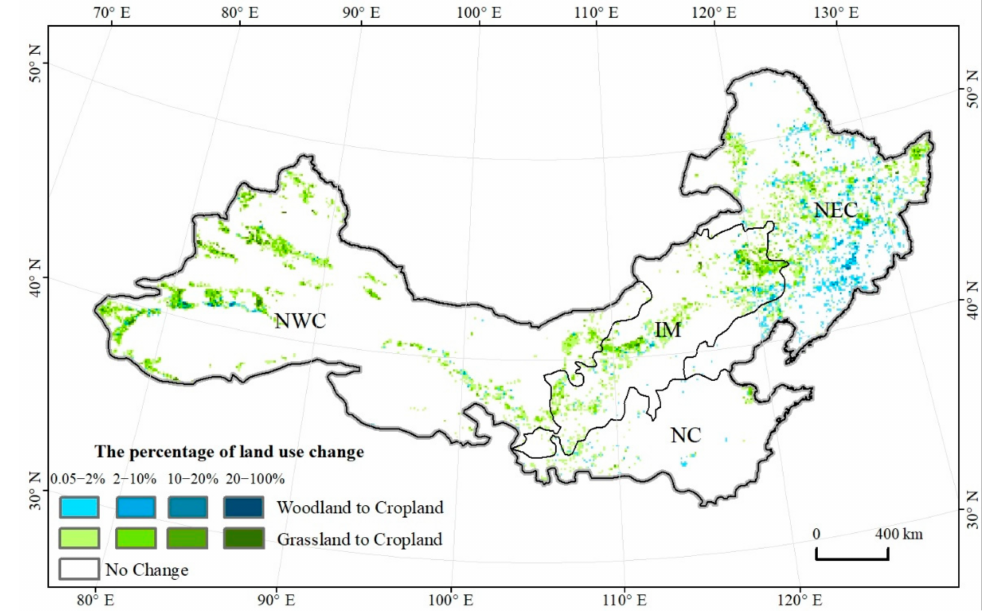
Figure 2. Distribution of cropland expansion areas in northern China from 2000 to